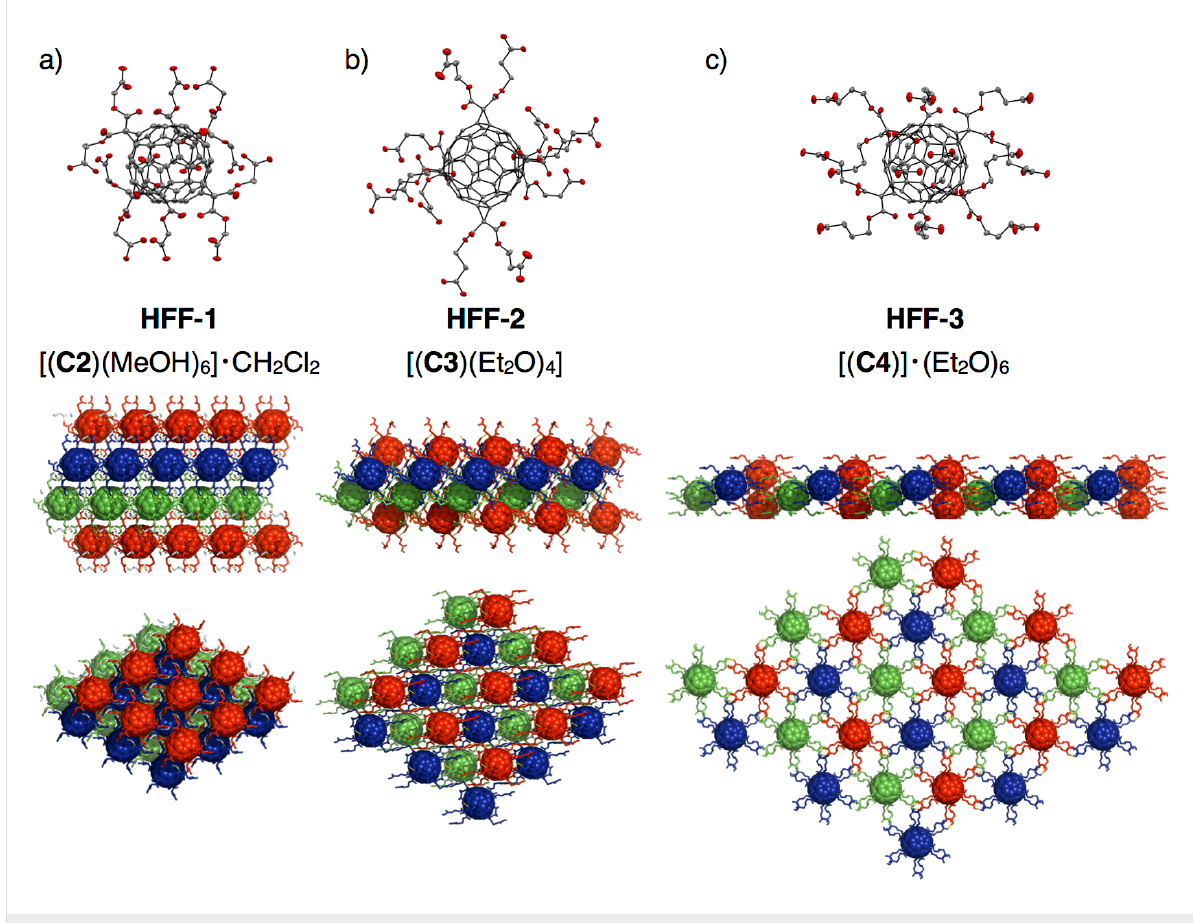
Figure 3: Face centered cubic arrangement of [60]fullerene dodecaacids for frameworks a) HFF-1 [57], b) HFF-2 and c) HFF-3 : ORTEP representa- tion of fullerene monomers (top, thermal ellipsoids set to 50% probability, carbon grey, oxygen red, hydrogen atoms omitted for clarity), side view indi- cating ABC-type packing (center) and top view indicating enlarged intralayer spacing for elongated derivatives (bottom); images are created with PyMOL [58].